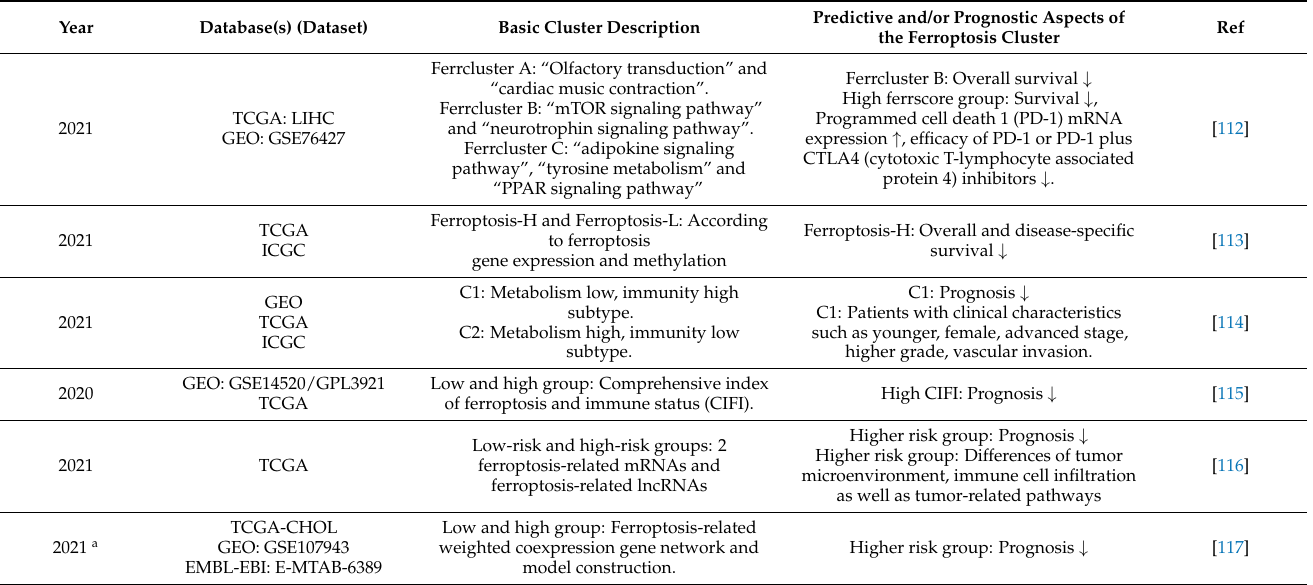
Table 2. Overview of in silico analysis of ferroptosis genes to develop a predictive and prognostic ferroptosis scoring system for HCC and CCC based on publicly accessible database sets.